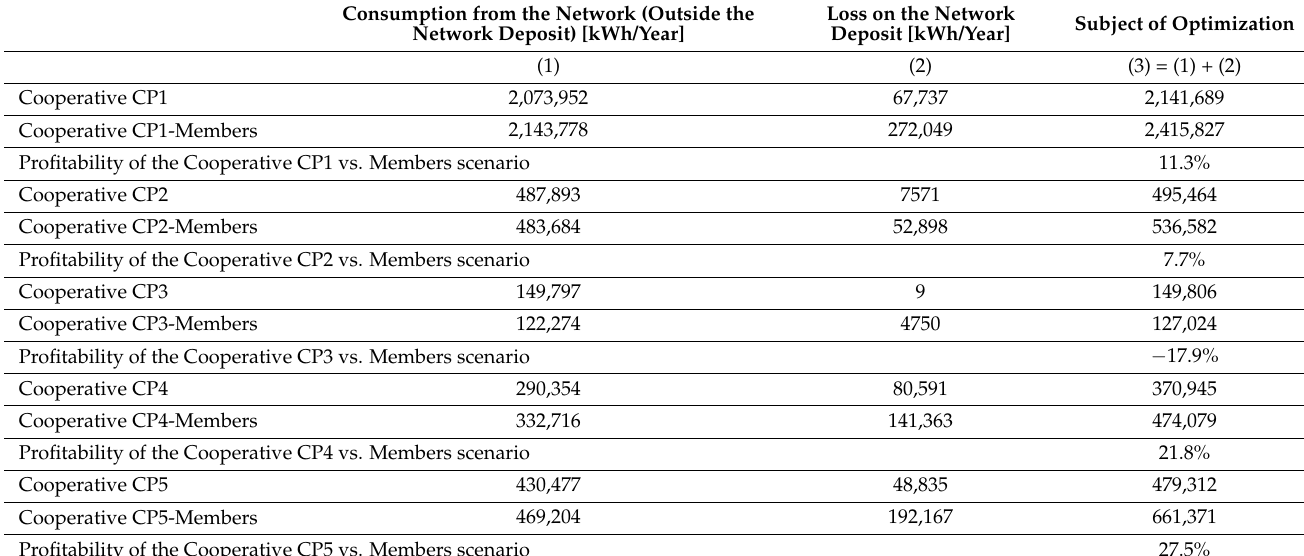
Table 6. Evaluation of optimization